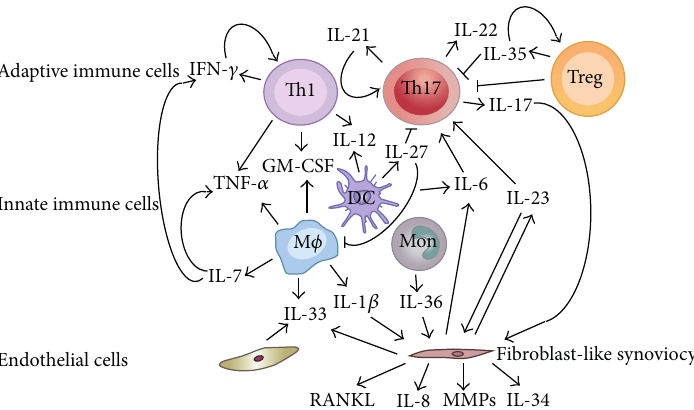
Figure 1: Network of investigational and prospective biomarkers in RA. A variety of different cell populations, including adaptive immune cells, innate immune cells, fibroblast-like synoviocytes, and endothelial cells, secrete cytokines as biomarkers not only in serum but also in synovial fluid and orchestrate inflammation and bone destruction in RA